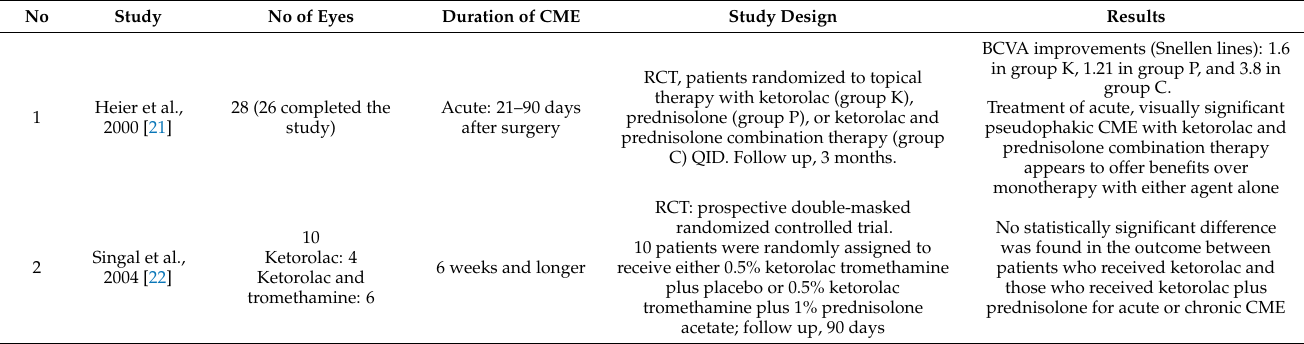
Table 3. Results of the studies analyzing the efficacy of the addition of topical corticosteroids to NSAID in the treatment of IGS that involved at least 10 cases and were published since